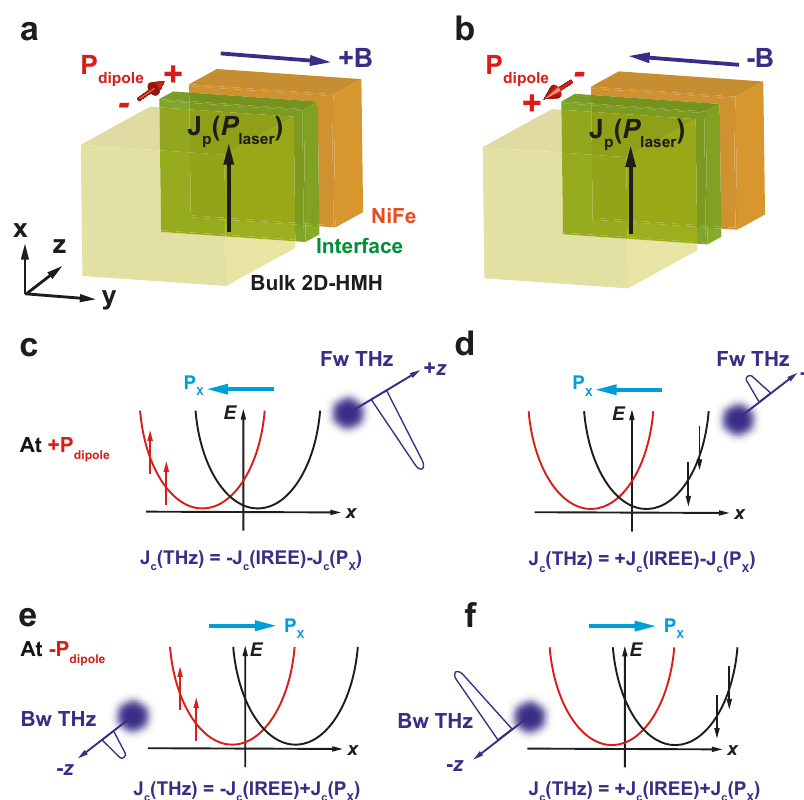
Fig. 5 Schematic illustration of the shifted Rashba bands and resulting asymmetric THz emission. a , b Formation of an electric polarization p dipole ð z Þ along the z -axis across the interfacial layered structure of the 2D-HMH fi lm in the vicinity of the 2D-HMH/NiFe interface under positive ( + B ) and negative ( − B ) magnetic fi elds, respectively. J p ð P laser Þ is the polarization current along the x -direction induced by linear polarization of the laser pump pulse. c, d A sketch of the shifted Rashba bands in the presence of momentum shift, P x < 0 at the + p dipole ð z Þ side according to Eq. (2). The red (black) arrows indicate the injected spin polarization at + B ( − B ) magnetic fi eld. e, f The shifted Rashba bands at the − p dipole ð z Þ side ( P x > 0). The generated THz emission containing both the fi eld-dependent IREE and the fi eld-independent momentum shift components is shown at different fi elds and surfaces that account for the asymmetric THz